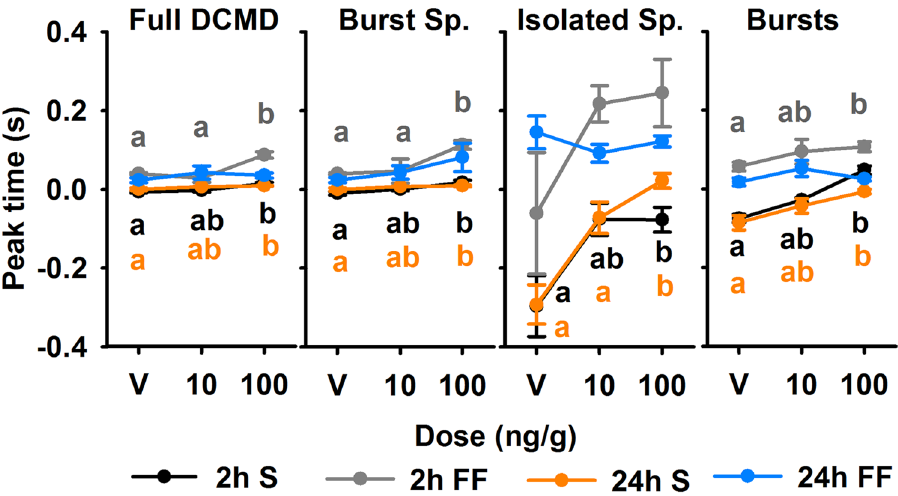
Figure 7. Time of maximum firing rate relative to collision (peak time; mean ± SEM) across doses and background types at 2 and 24 hours after treatment. Significant results of post hoc analyses are indicated with letters colour coded to the respective background type.